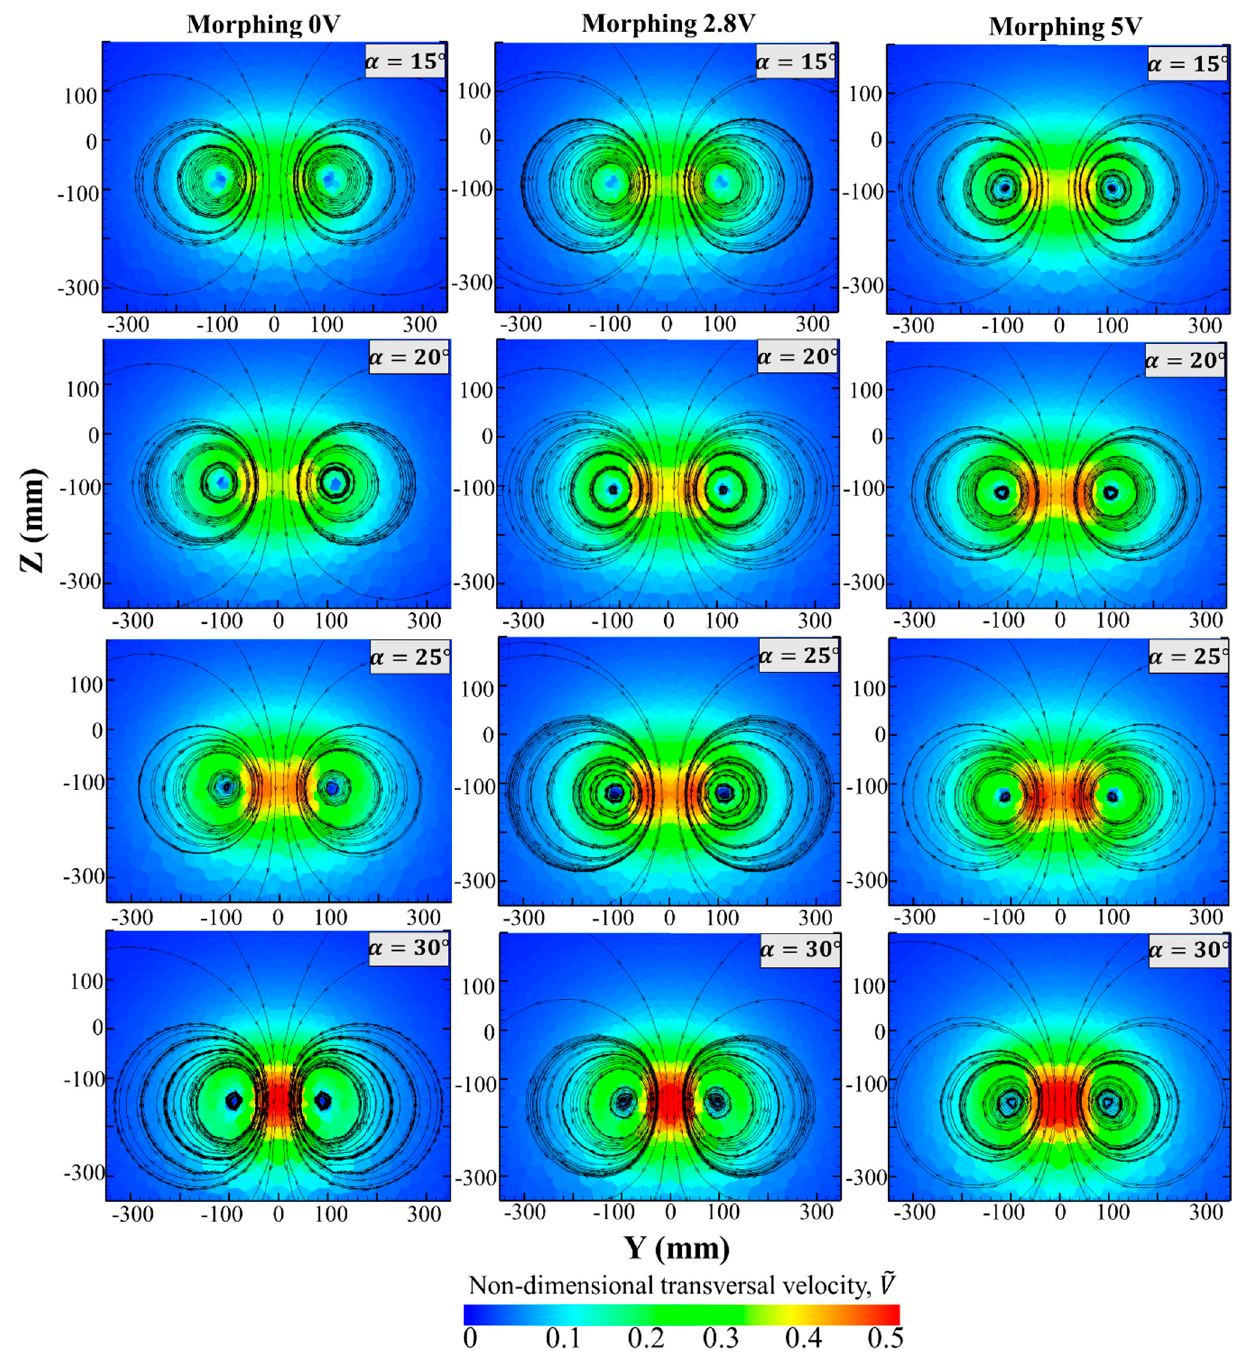
Figure 9. Non-dimensional transversal velocity maps for all wing configurations: morphing 0 V, 2.8 V and 5 V ( U ∞ = 10 m/s, β = 0 ◦ ).